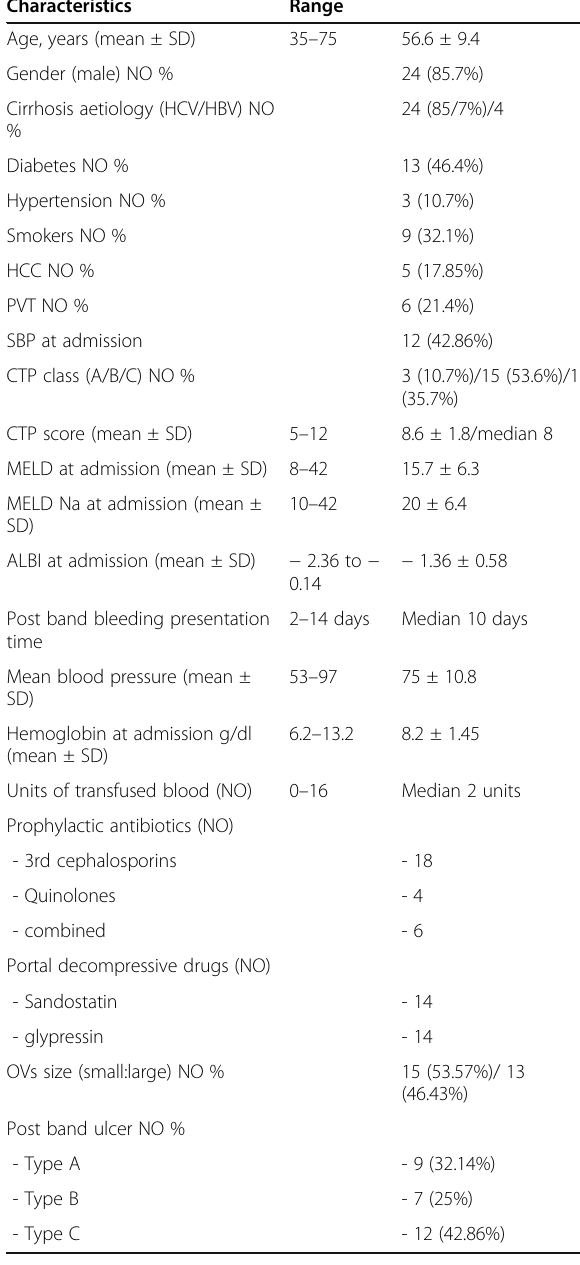
Table 1 Demographic, clinical, and endoscopic characteristics of the patients: